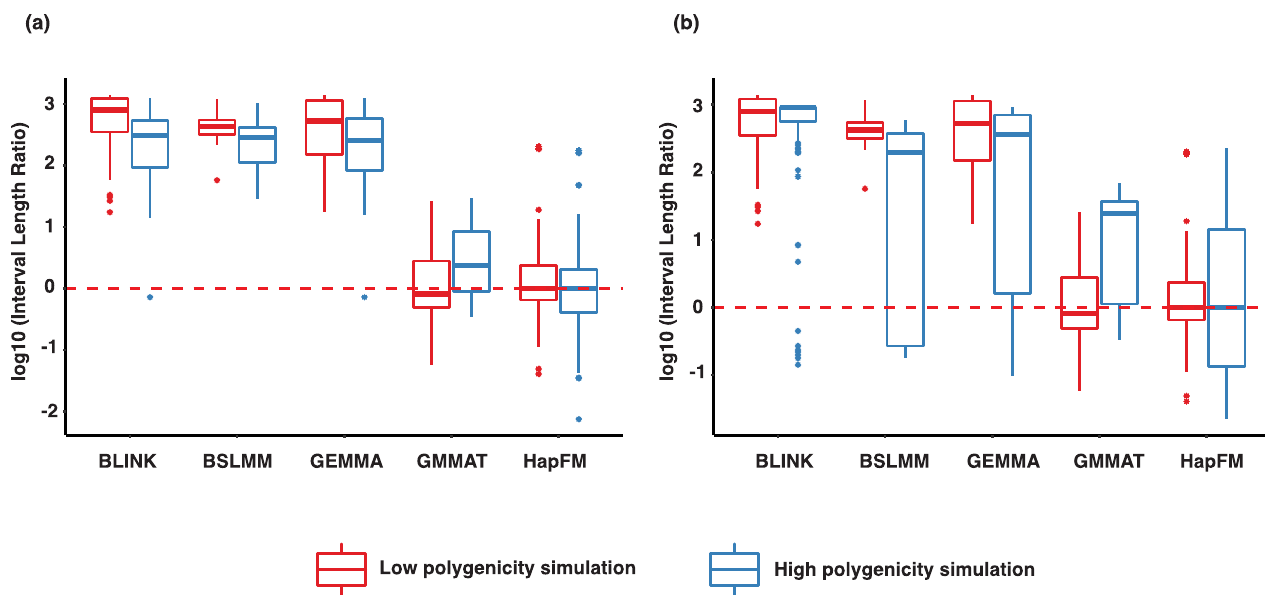
Fig 4. Mapping interval comparisons of different GWAS algorithms in the simulations. The interval length ratio was calculated by normalizing to the mean of HapFM’s interval length. The red dash line indicates the average interval length of significant loci identified by HapFM. (a). Interval length of significant loci (FDR < 0.05) identified by different GWAS algorithms from the simulated Arabidopsis GWAS datasets (b). Interval length of significant loci (FDR < 0.05) identified by different GWAS algorithms from the simulated soybean GWAS datasets.